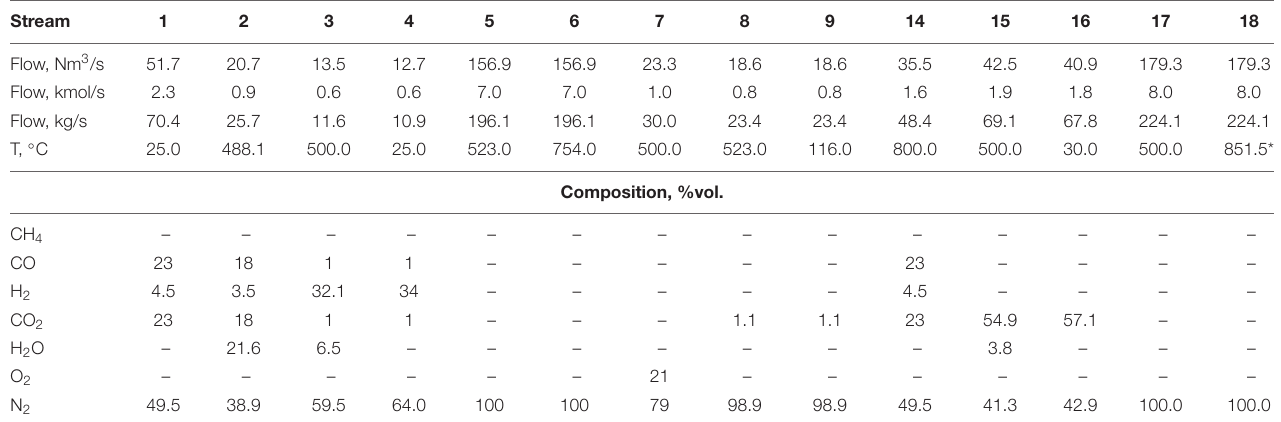
FIGURE 5 | Temperature profiles at initial and final conditions in every stage of the Ca-Cu looping process for the conditions assumed in the reference case (plug flow without axial dispersion, ideal heat exchange between gas and solids, and reactions taking place in sharp reaction fronts are assumed). (A) CASOH stage, (B) oxidation stage, (C) redcution/calcination stage, and (D) heat removal stages. TABLE 3 | Main characteristics of the gaseous streams of the Ca-Cu looping process (see Figure 3 ) obtained by solving the mass and energy balances in the reference